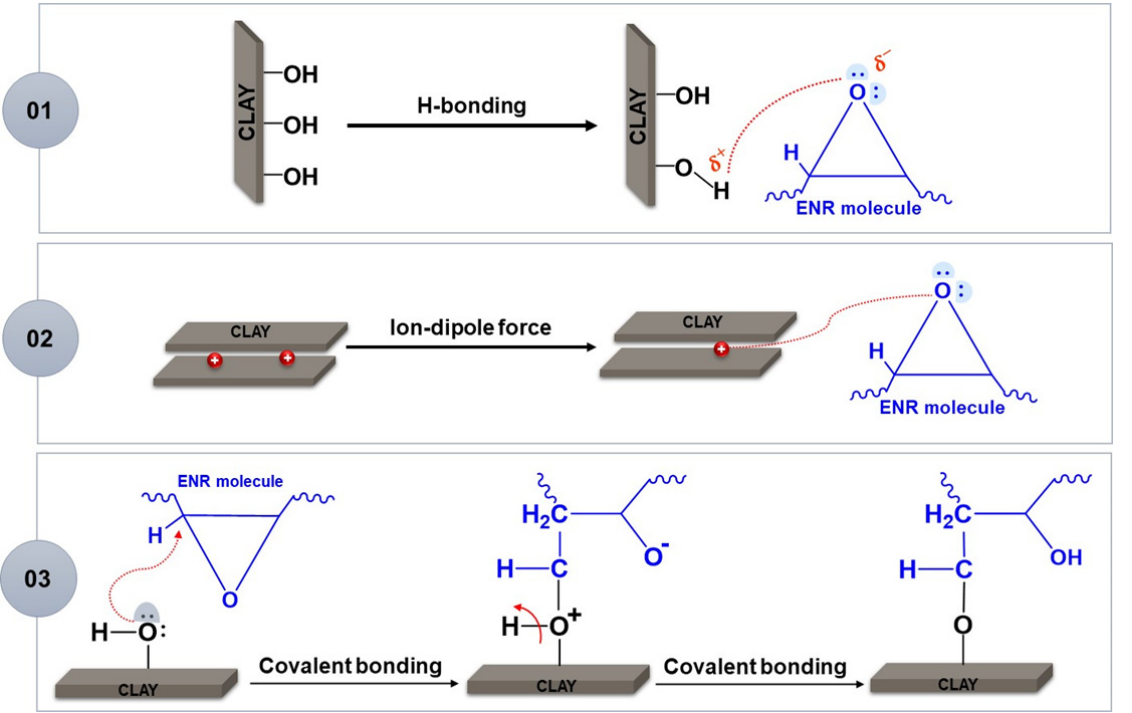
Figure 11. The proposed model and interaction of ENR and bentonite clay in ENR/Clay composites.